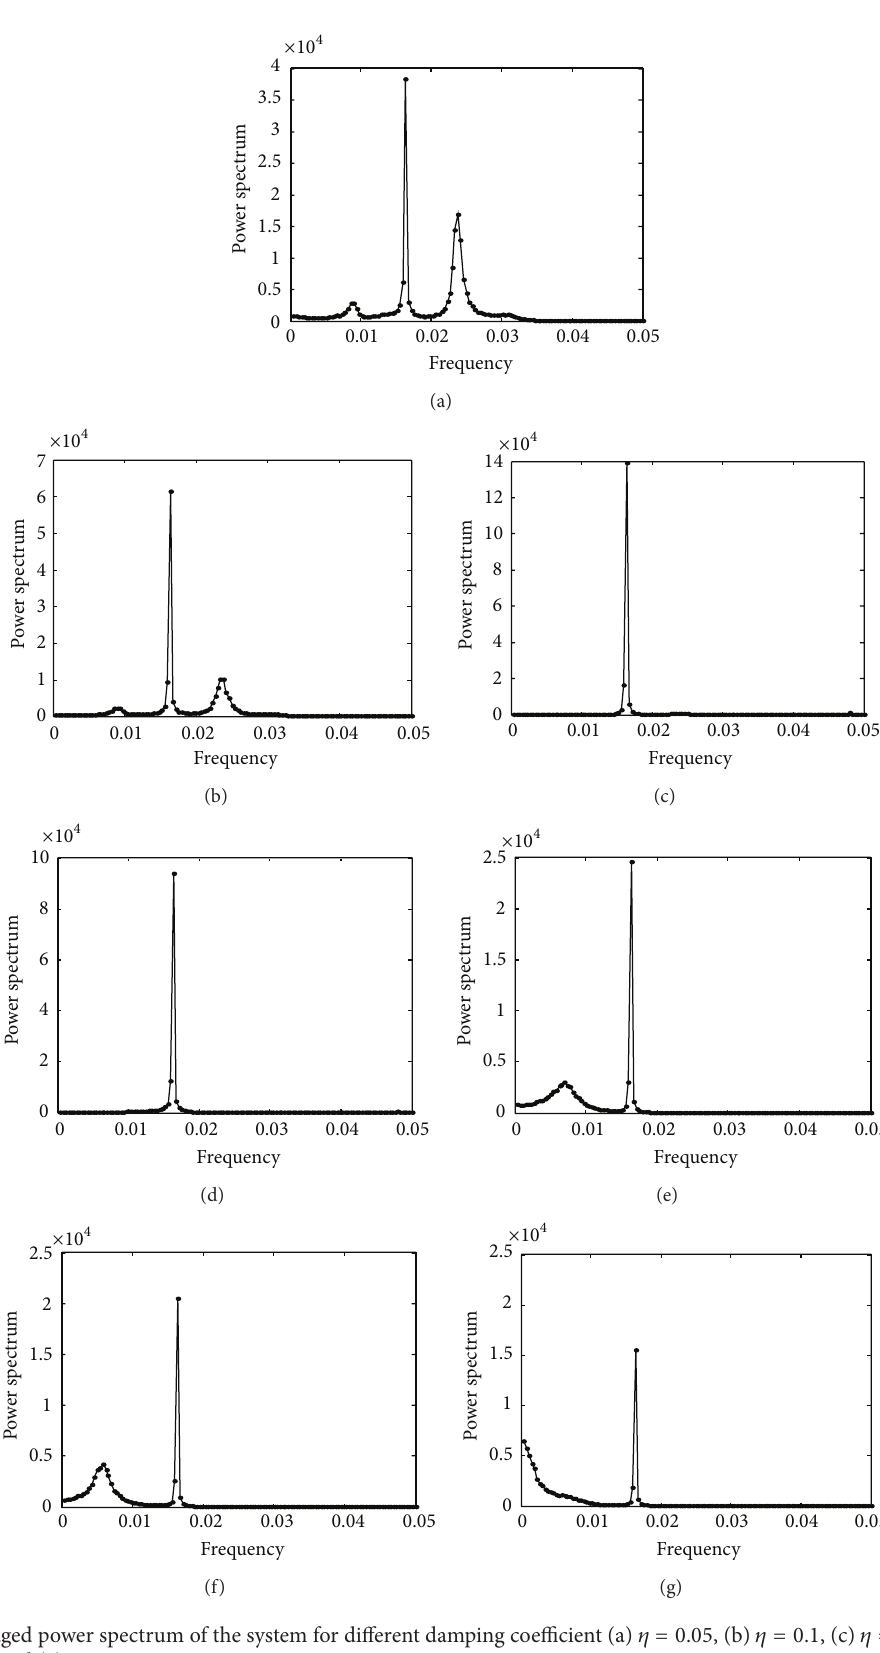
Figure 3: The averaged power spectrum of the system for different damping coefficient (a) 𝜂 = 0.05 , (b) 𝜂 = 0.1 , (c) 𝜂 = 0.3 , (d) 𝜂 = 0.6 , (e) 𝜂 = 0.9 , (f) 𝜂 = 1.0 , and (g) 𝜂 = 1.3